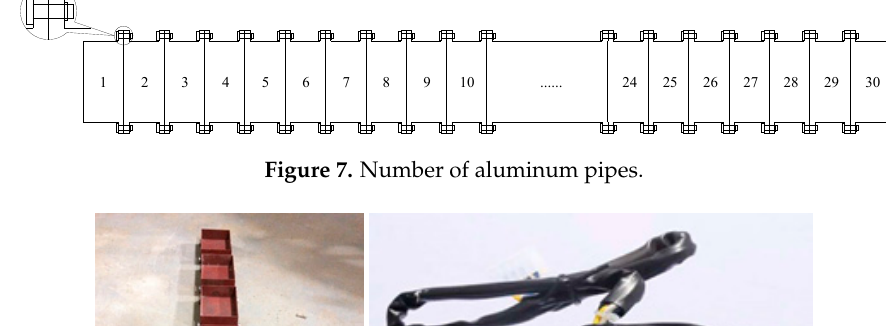
Figure 8. Simulated train load: ( a ) moving train; ( b ) traction device.